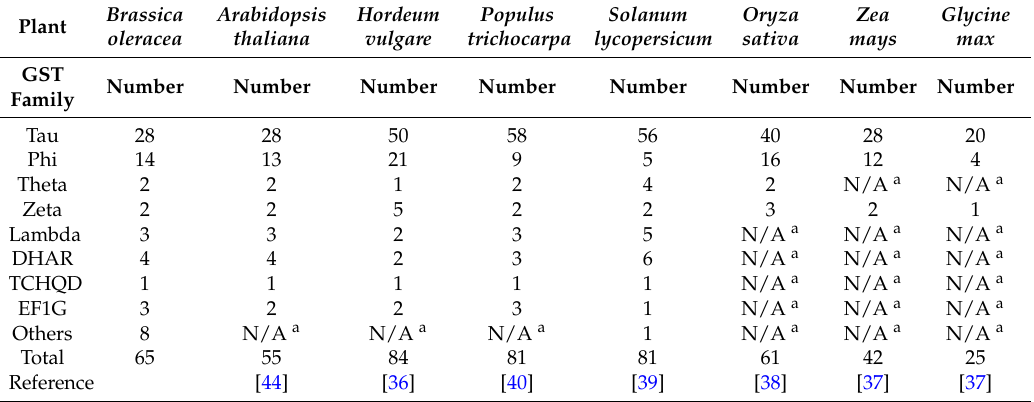
Table 1. Number of GST genes content in Brassica oleracea , Arabidopsis thaliana , Hordeum vulgare , Populus trichocarpa , Solanum lycopersicum , Oryza sativa , Zea mays and Glycine max